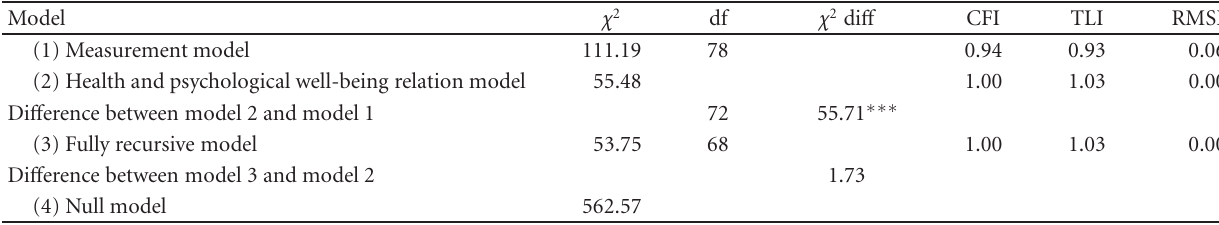
Table 3: Fit indices for nested sequence of cross-sectional